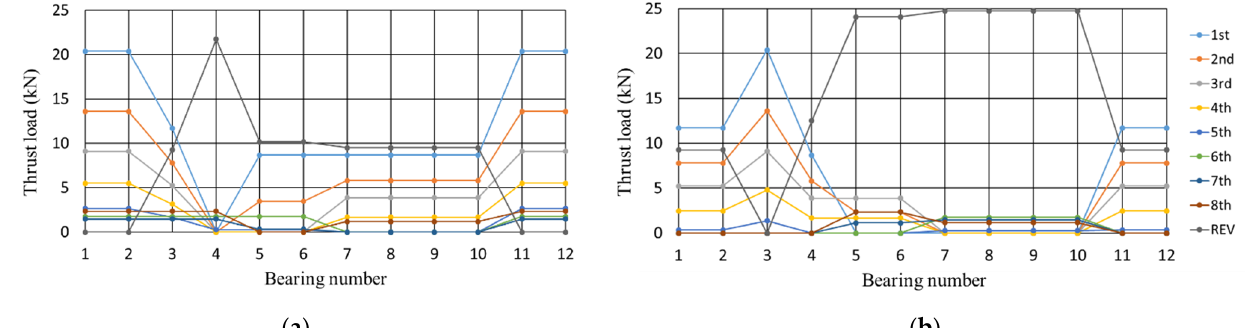
Figure 5. Bearing thrust loads resulting from ( a ) RRLR and ( b ) LLRR directions of helix angles.